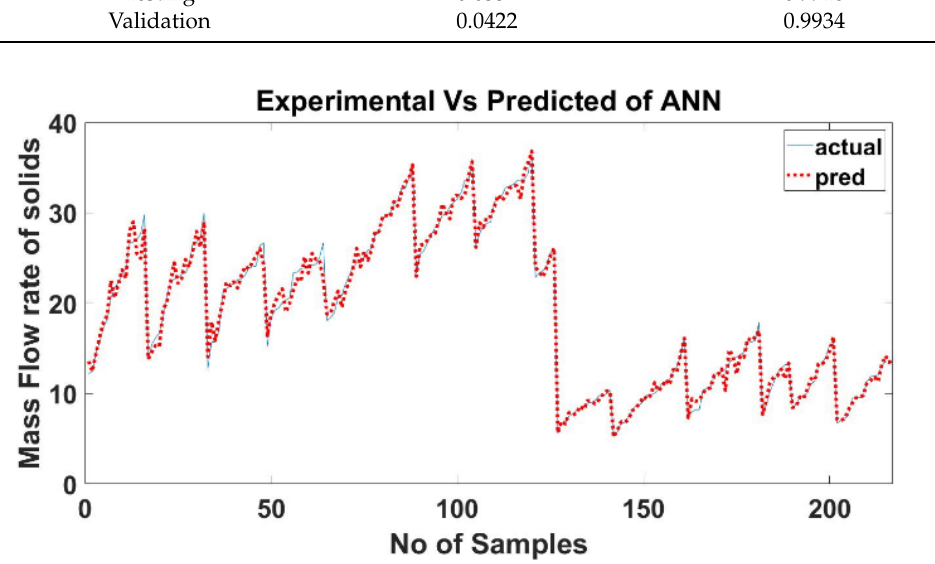
Figure 10. Comparison of experimental and predicted output by ANN.